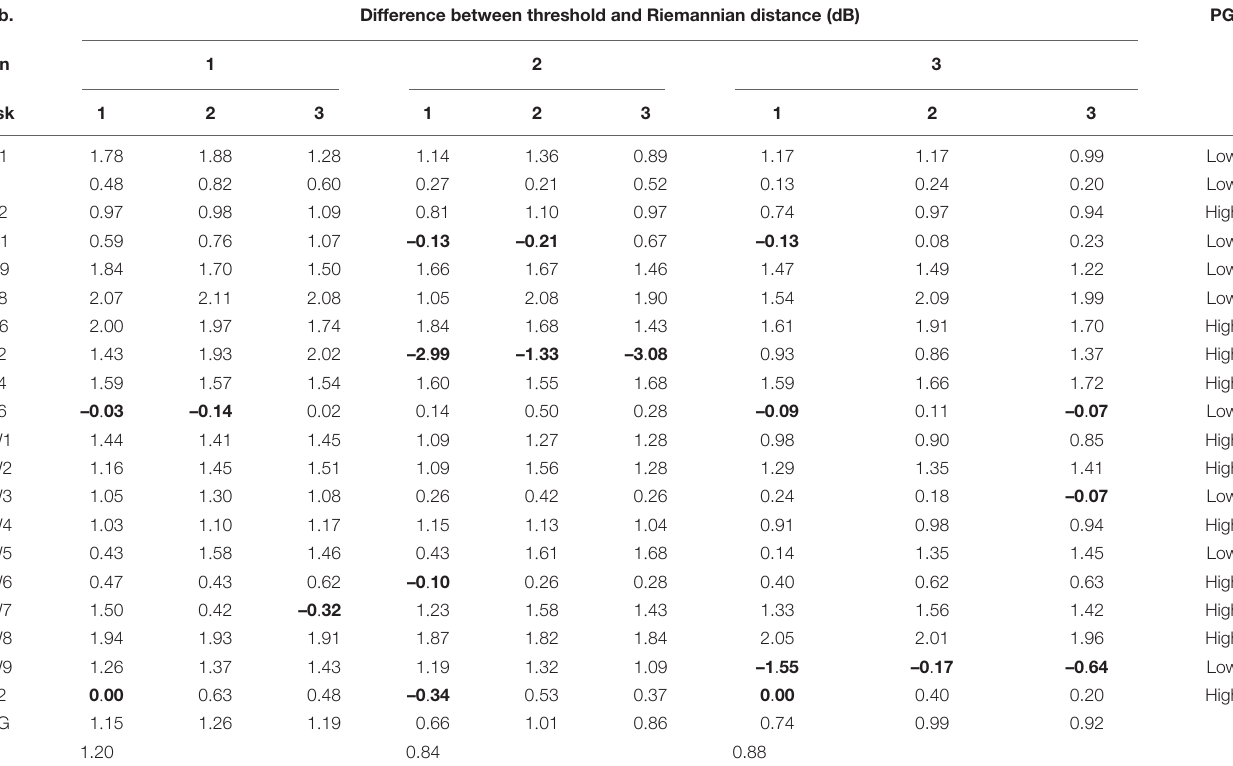
TABLE 1 | Absolute differences between the threshold (Eq. 8) and the standardized Riemannian distances of the task-run EEG (Eq. 7) for the low and high PG. Sub.